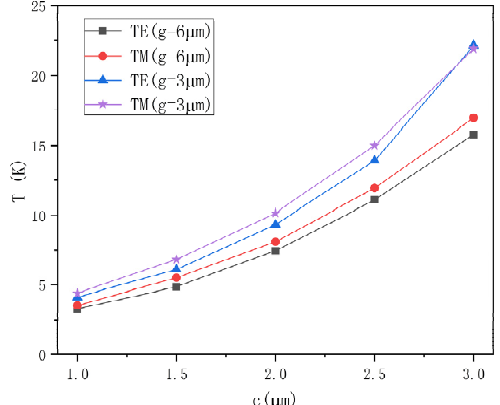
Figure 3. Relationship between the minimum temperature and the width of the core in the heating region for the electrode widths of 3 and 6 µm.